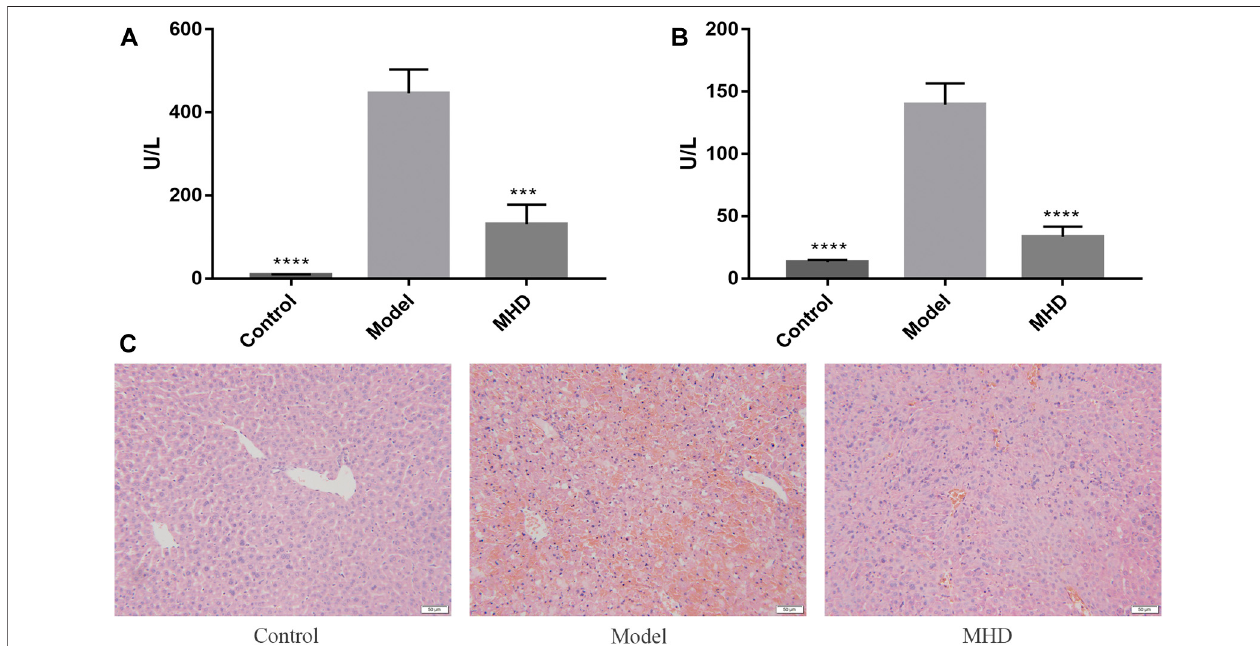
FIGURE 1 | Effects of MHD on serum ALT (A) and AST (B) levels in mice with acute liver failure induced by LPS/D-GalN. Values are shown in Mean ± SEM. *** p < 0.001, **** p < 0.0001 vs model group. (C) Images of H&E stained liver cells (original magni fi cation × 200).